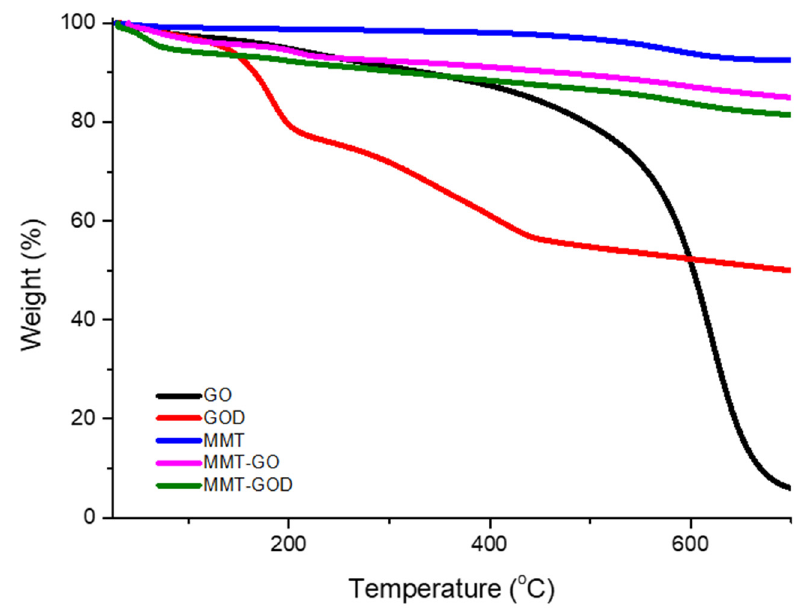
Table 3. Thermal properties for the nanoreinforcing agents.